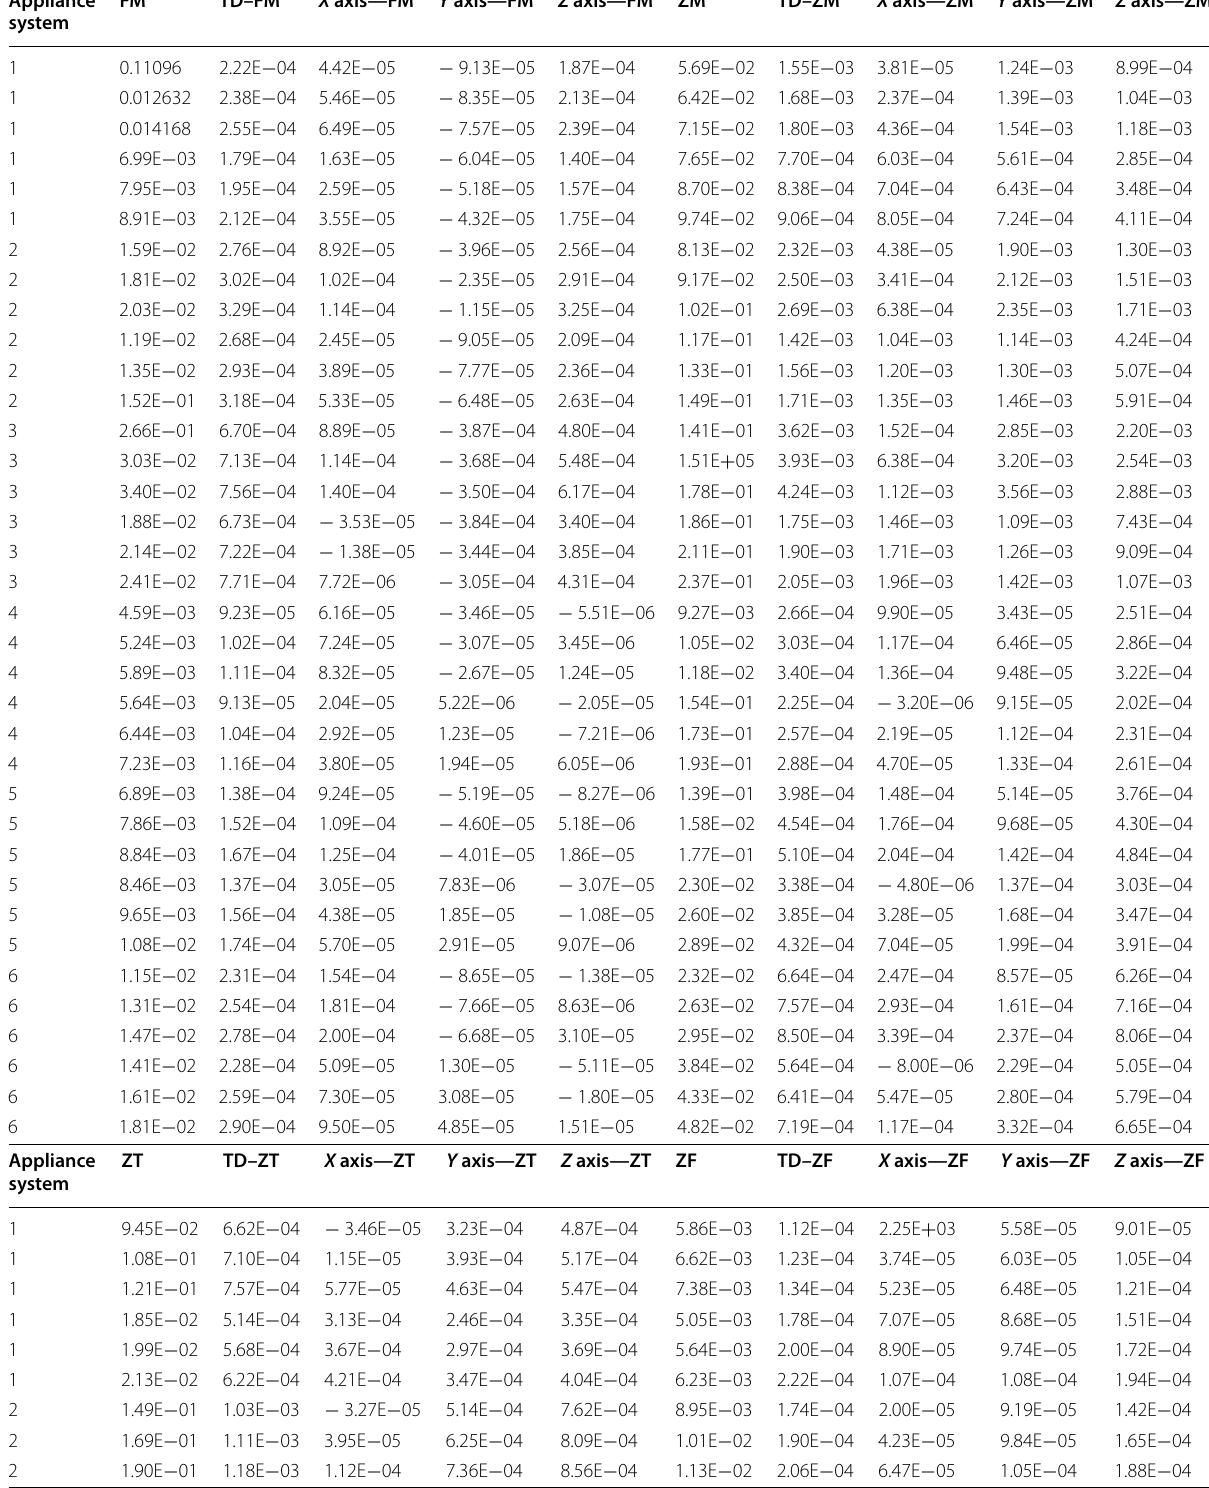
Table 2 (a) Stress distribution and displacement in the sutures with miniplate, (b) stress distribution and displacement in the sutures with